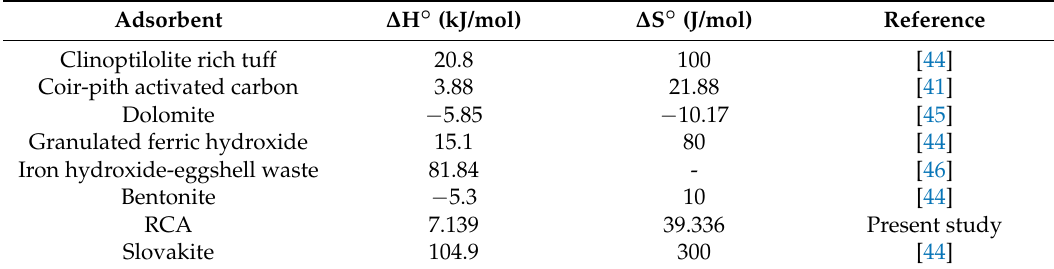
Figure 9. The comparison of different type of P before and after test.